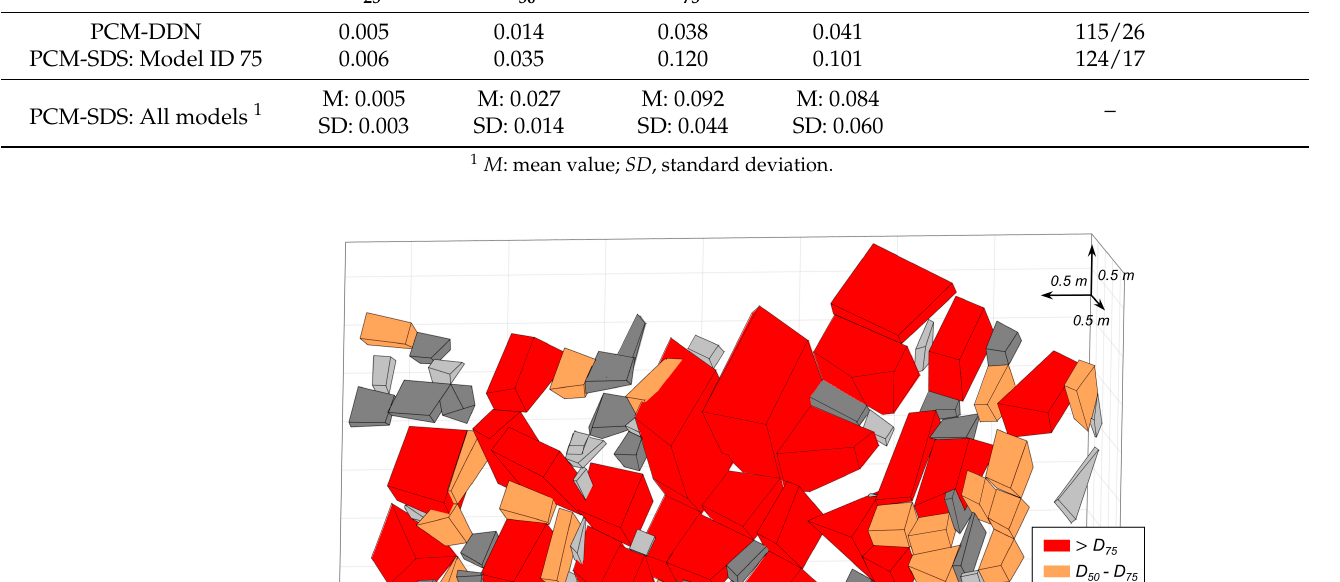
Table 3. Summary of block characterization results of Site 1 acquired from two procedures.